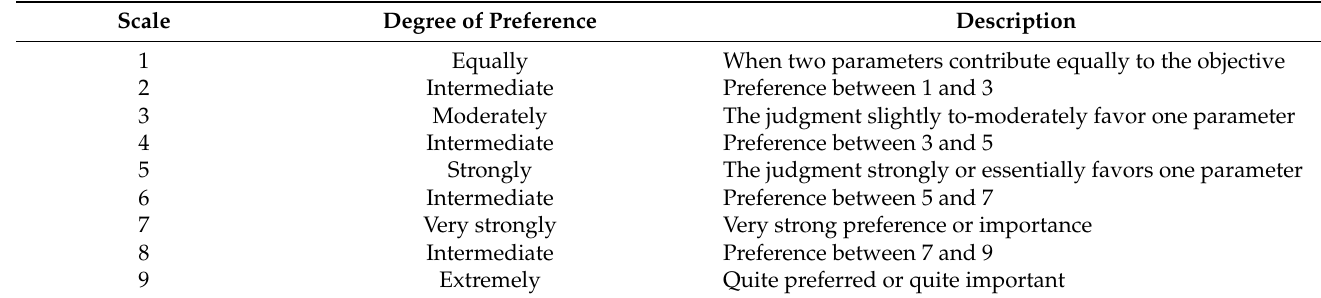
Table 1. Saaty’s scale of preference between two factors in